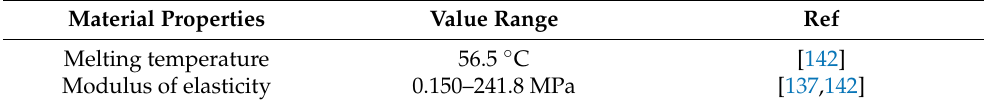
Table 4. Physical and mechanical properties of PEG and its composite material.